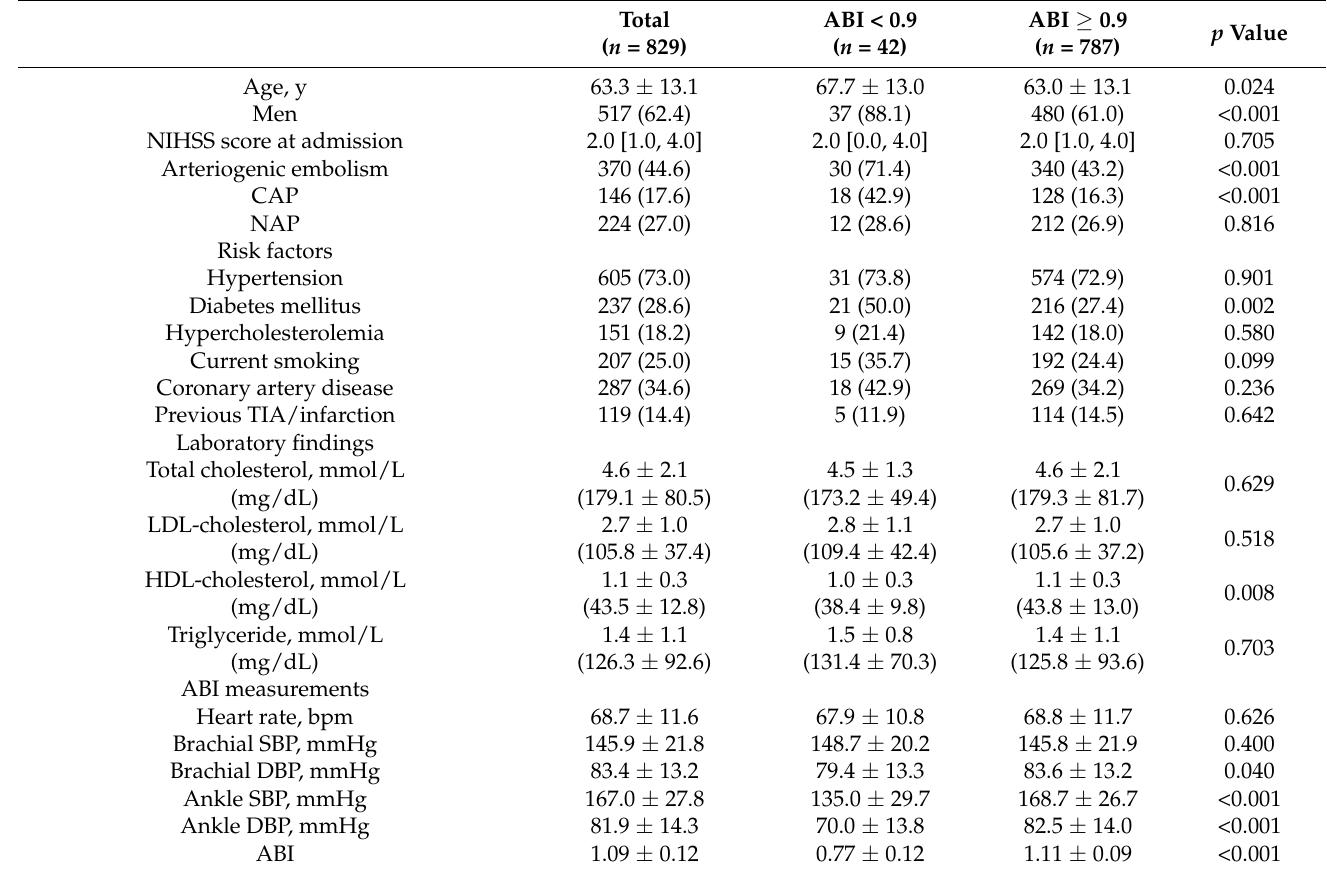
Table 1. Patient demographic and clinical